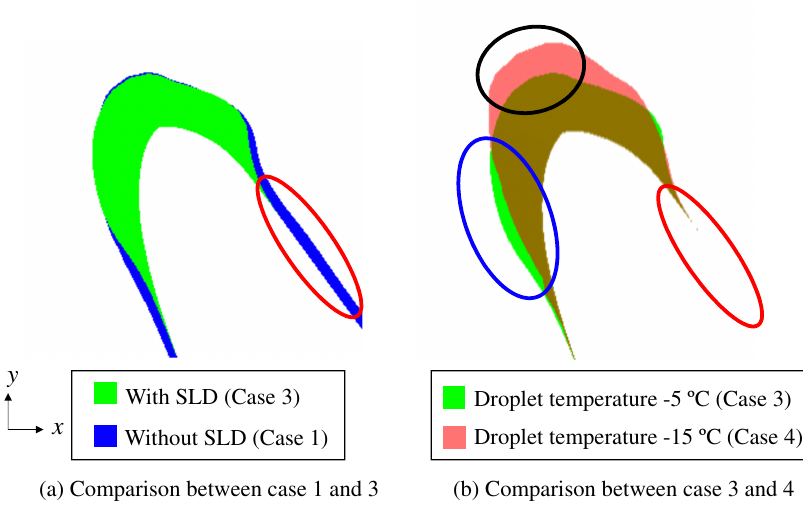
Figure 7. Ice shape around the leading edge at the